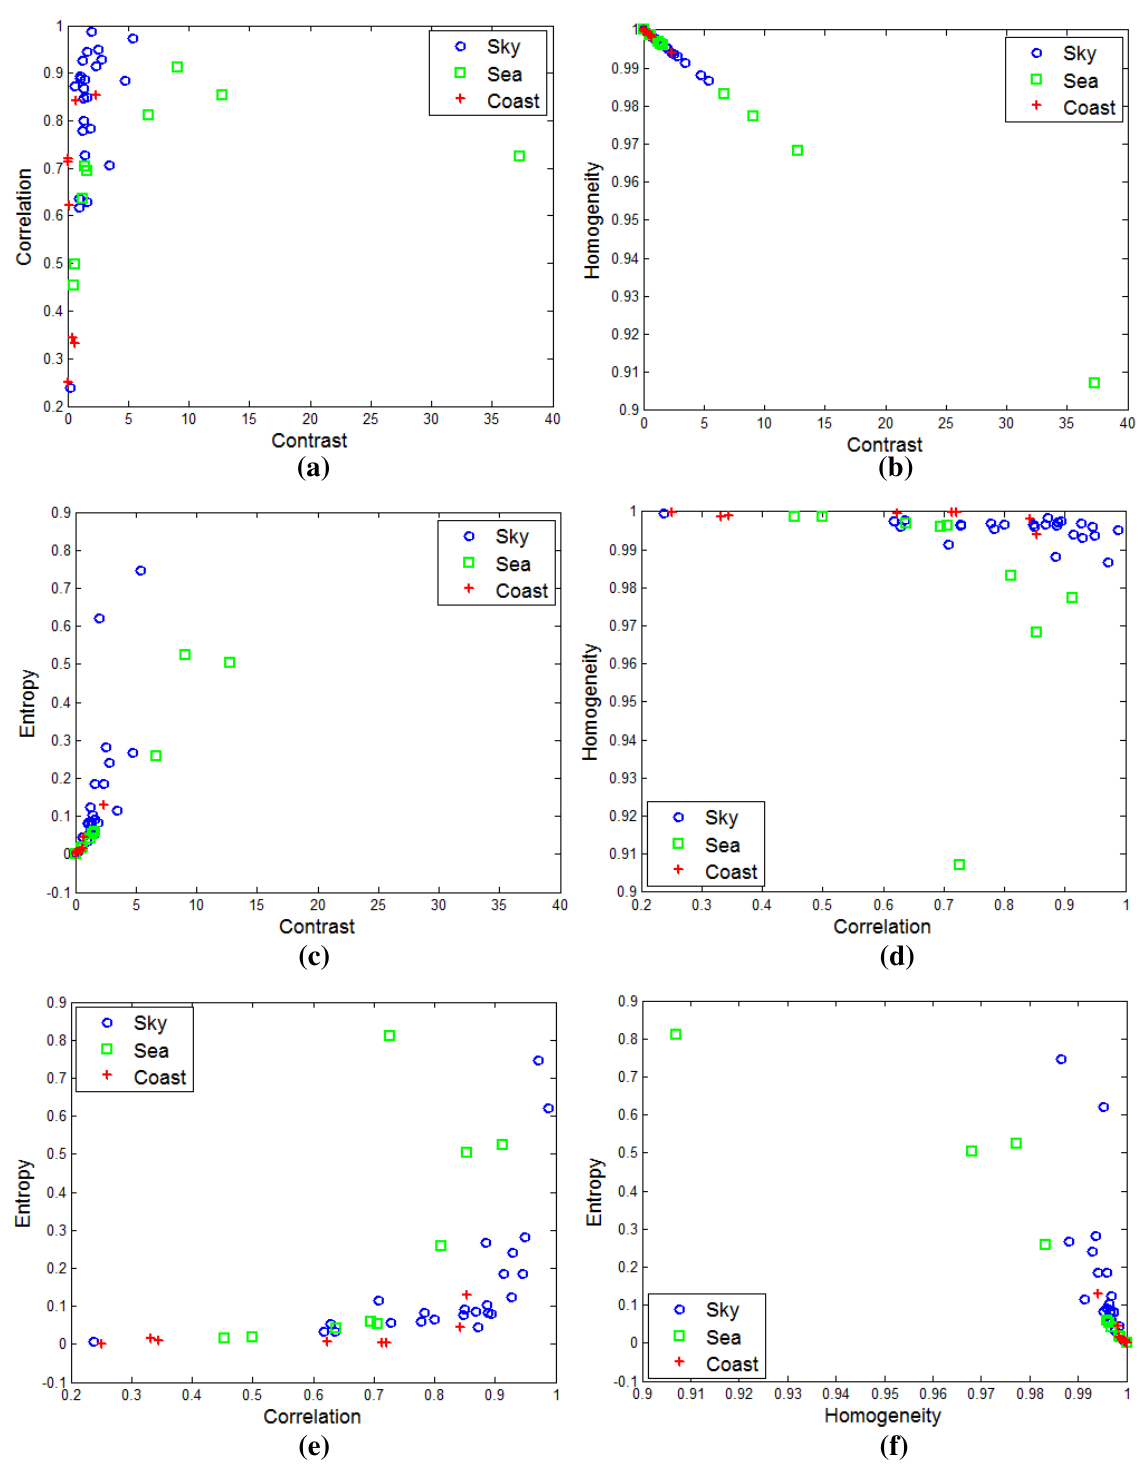
Figure 7. Distributions of the gray level co-occurrence matrix (GLCM)-based thermal texture for each region: ( a ) contrast vs. correlation; ( b ) contrast vs. homogeneity; ( c ) contrast vs. entropy; ( d ) correlation vs. homogeneity; ( e ) correlation vs. entropy; ( f ) homogeneity vs.